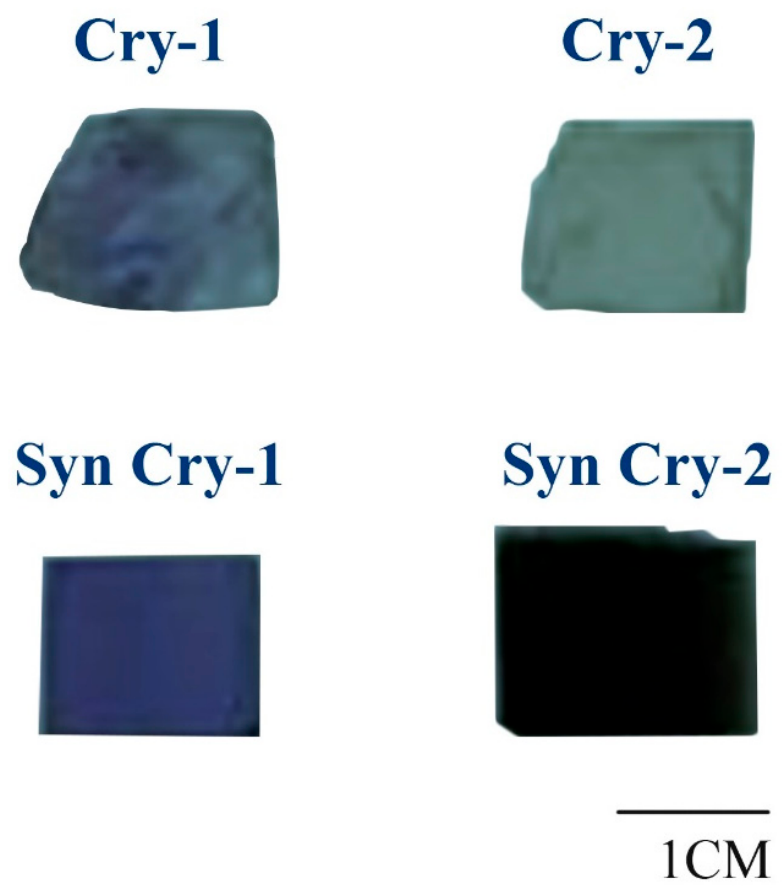
Figure 1. Photos of Cry-1, Syn Cry-1, Cry-2 and Syn Cry-2 samples.